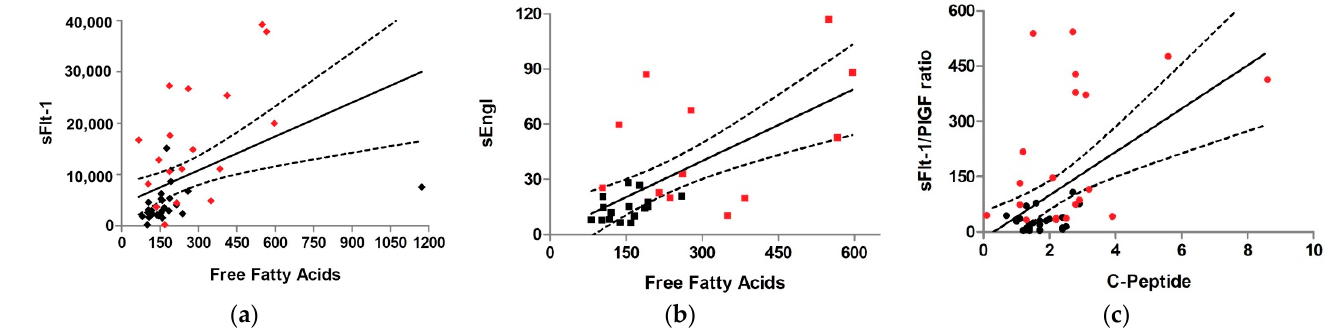
Figure 1. Linear regression with 95% confidence interval for prediction of angiogenic factor elevation ( p < 0.05): ( a ) Elevation of free fatty acids (FFA) was a predictor for elevation of soluble fms-like tyrosine kinase-1(sFlt-1) ( b ) and soluble endoglin(sEng) ( c ) C-peptide was a predictor for high sFlt1/PlGF ratio. The control group is represented in black; the preeclampsia group is shown in red. The units of measurement for these parameters were: FFA (mg/dL), sFlt-1 (pg/mL), sEng (ng/mL), C-peptide (ng/mL). PIGF: placental growth factor.